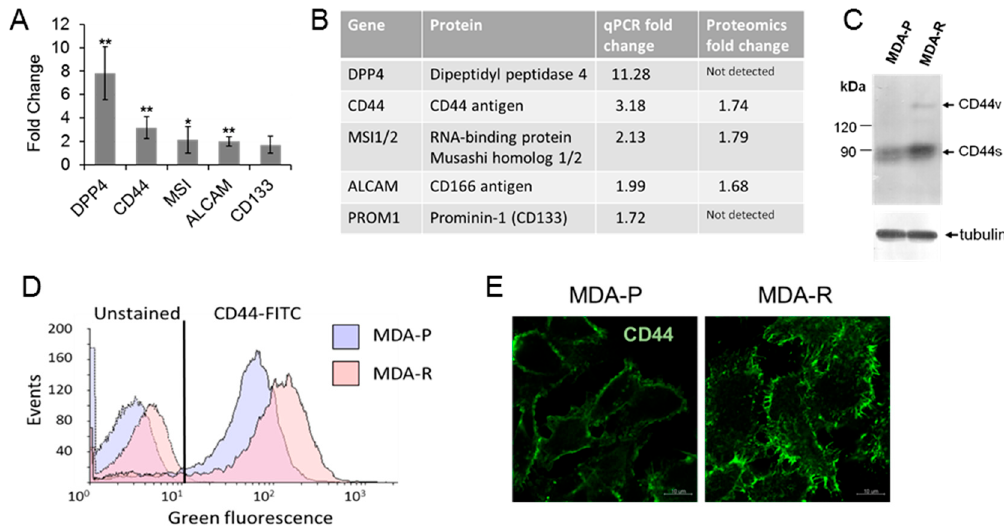
Figure 5. RH1 resistant cells show an increased level of CSC markers. ( A ). Relative expression of selected CSC markers measured by RT-qPCR in MDA-R compared to MDA-P. The results are the mean of 3 independent experiments; bars are ± SD (ANOVA; * p < 0.05; ** p < 0.01). ( B ). Comparison of CSC markers detected by RT-qPCR with quantitative proteomic analysis results. ( C ). Western blot analysis of various isoforms of CD44 expression in MDA-P and MDA-R cell lines. ( D ). Flow cytometry aggregated data graph showing autofluorescence and CD44 expression in MDA-P and MDA-R cells. Data combined from unstained and CD44-FITC antibody-stained samples. E. Representative comparative confocal images of CD44 expression in MDA-P and MDA-R cells. Scale bar: 10 µm.